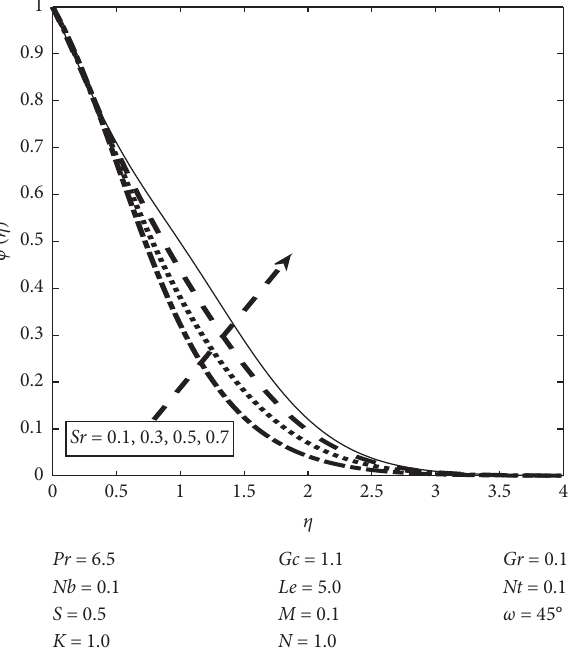
Figure 18: Concentration profile for several values of Sr .